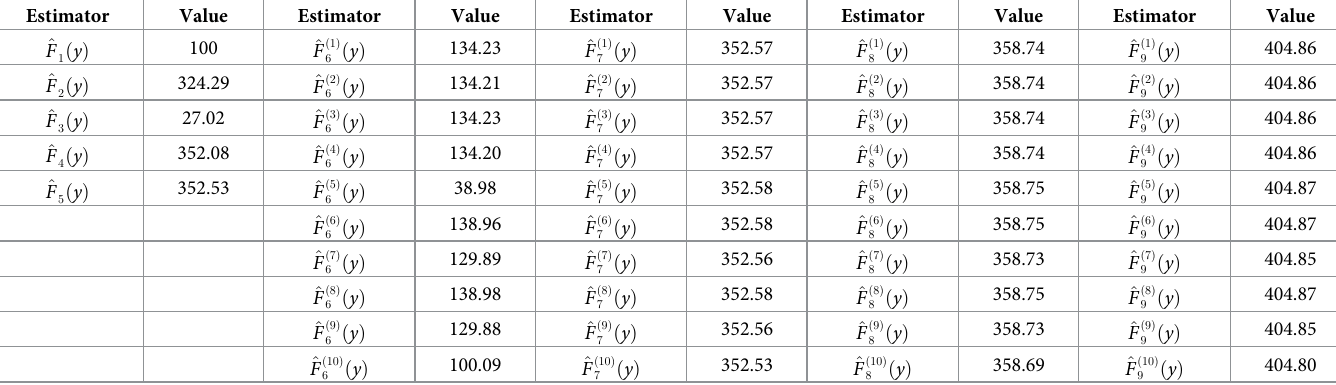
Table 7. PREs of distribution function estimators using Population V.